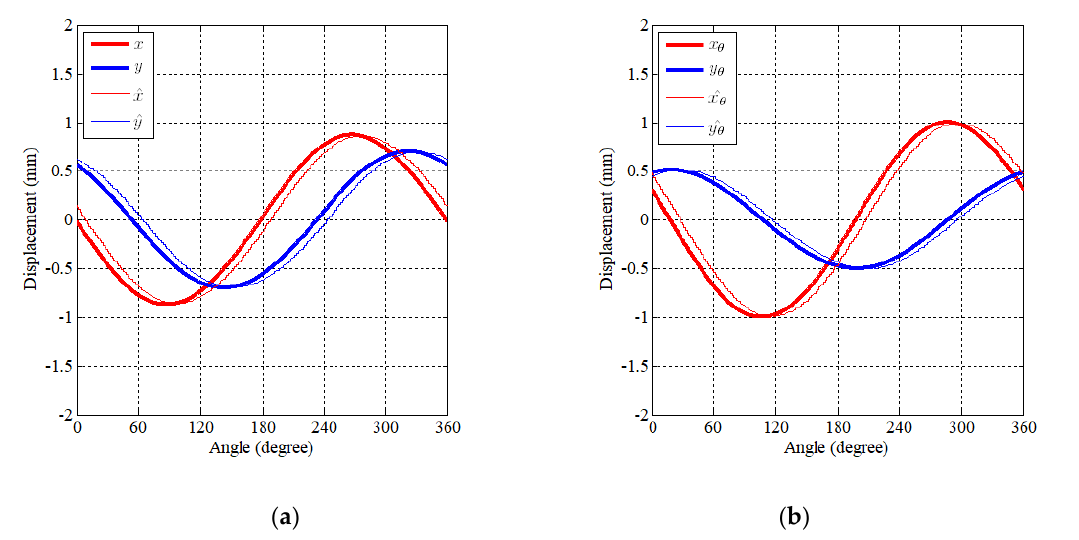
Figure 12. Displacement estimation of elliptical motion (  : 1mm,  : 0.5mm,  : 35deg.) ( a ) Figure12. Displacementestimationofellipticalmotion( α : 1mm, β : 0.5mm, θ : 35deg.) ( a )Displacement Displacement in the X–Y reference frame and ( b ) displacement in the X  –Y  reference frame. in the X–Y reference frame and ( b ) displacement in the X θ –Y θ reference